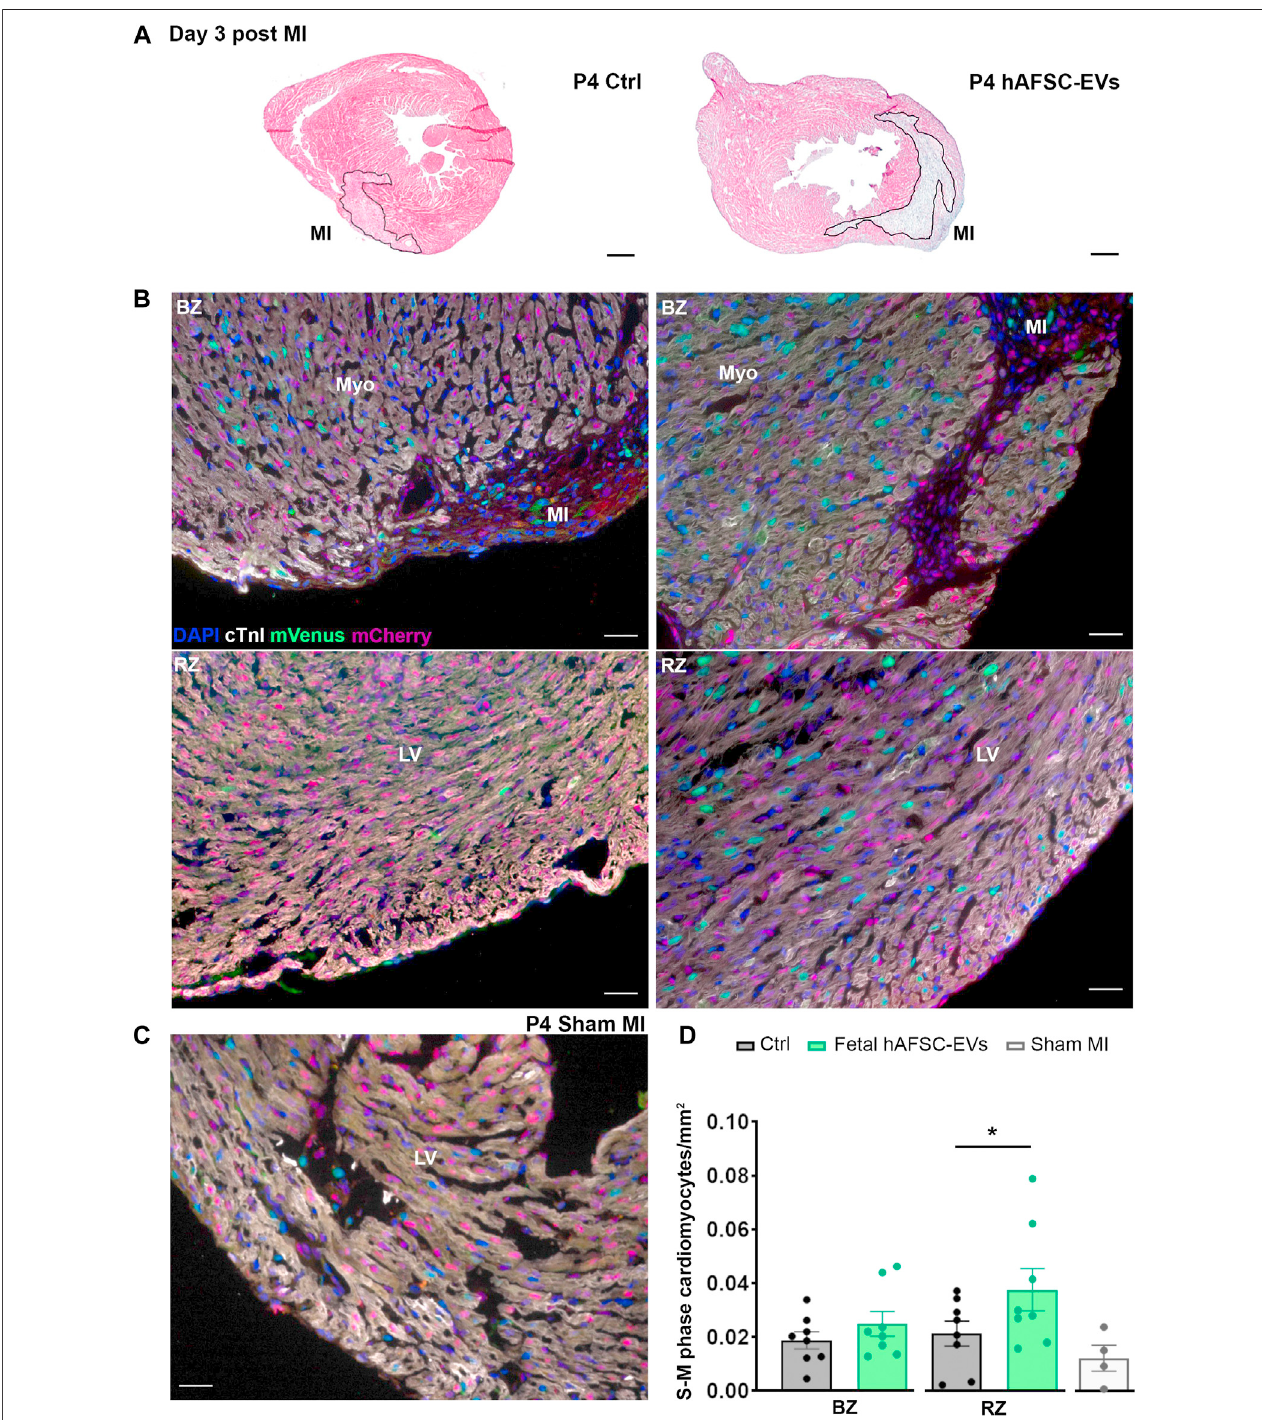
FIGURE 4 | In vivo cardiogenic effect of fetal hAFSC-EVs on P4 neonatal mouse heart at 3 days post MI. (A) Representative pictures of hematoxylin and eosin staining on cryo-sections of R26pFUCCI2 +/ − 4-day-old (P4) mouse myocardial tissue in: vehicle-treated control condition (PBS solution, left panel, Ctrl) and following intraperitonealinjectionof4.5 μ gfetalhAFSC-EVs(hAFSC-EVs,rightpanel);myocardialinfarctarea(MI)istracedinblack,scalebar:300 µm. (B) Representativepictures of immunostaining analysis on cryo-sections of R26pFUCCI2 +/ − 4-day-old (P4) mouse myocardial tissue in: vehicle-treated control condition (PBS solution, left panel, Ctrl), following intraperitoneal injection with 4.5 μ g fetal hAFSC-EVs (hAFSC-EVs, right panel), or in Sham control condition [ (C) , Sham MI] for DAPI (blue), cardiac troponin I (cTnI, white), mVenus-Geminin (mVenus, green), and mCherry-Cdt1 (mCherry, red), at 3 days post MI (P4 d3); scale bar: 50 µm. (D) Evaluation of mVenus- positiveandcTnI-positiveresidentcells(S-Mphasecardiomyocytes/mm 2